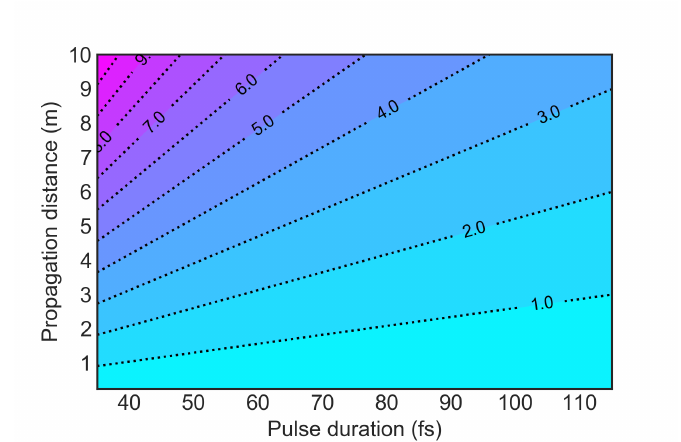
Figure 1. Estimate of B-integral accumulation for a freely-propagated 12-mJ, 1-cm Gaussian diameter beam of varying pulse